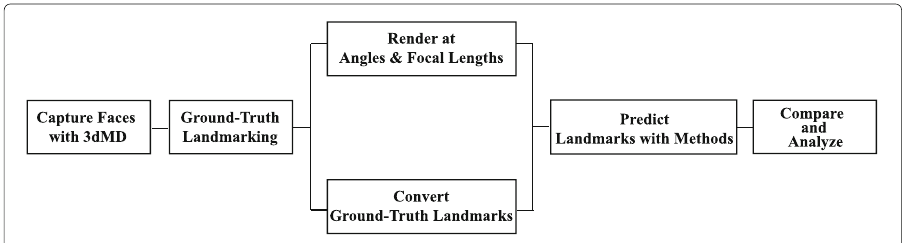
Fig. 5 Flow chart of the main process for measurement